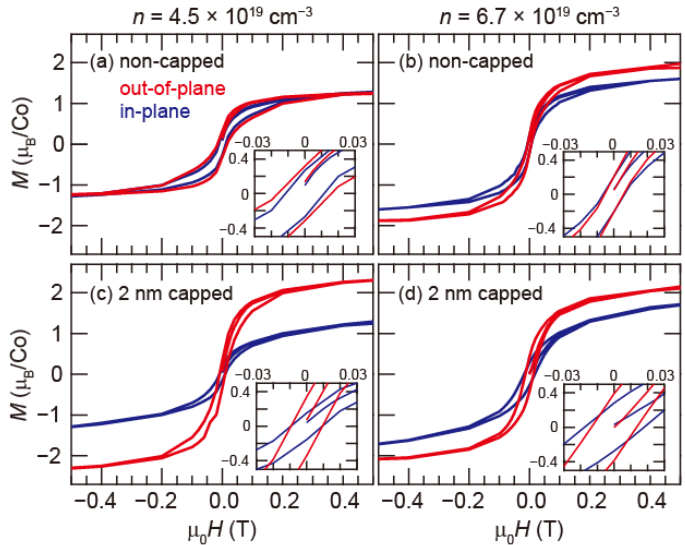
Figure 3. Out-of-plane (red) and in-plane (blue) magnetization curves at 300 K for anatase Ti 0.95 Co 0.05 O 2 − δ epitaxial thin films with different carrier density. ( a ) n = 4.5 × 10 19 cm − 3 and ( b ) n = 6.7 × 10 19 cm − 3 without capping layer; ( c ) n = 4.5 × 10 19 cm − 3 and ( d ) n = 6.7 × 10 19 cm − 3 with a 2-nm-thick capping layer. Insets denote magnified views at around a zero magnetic